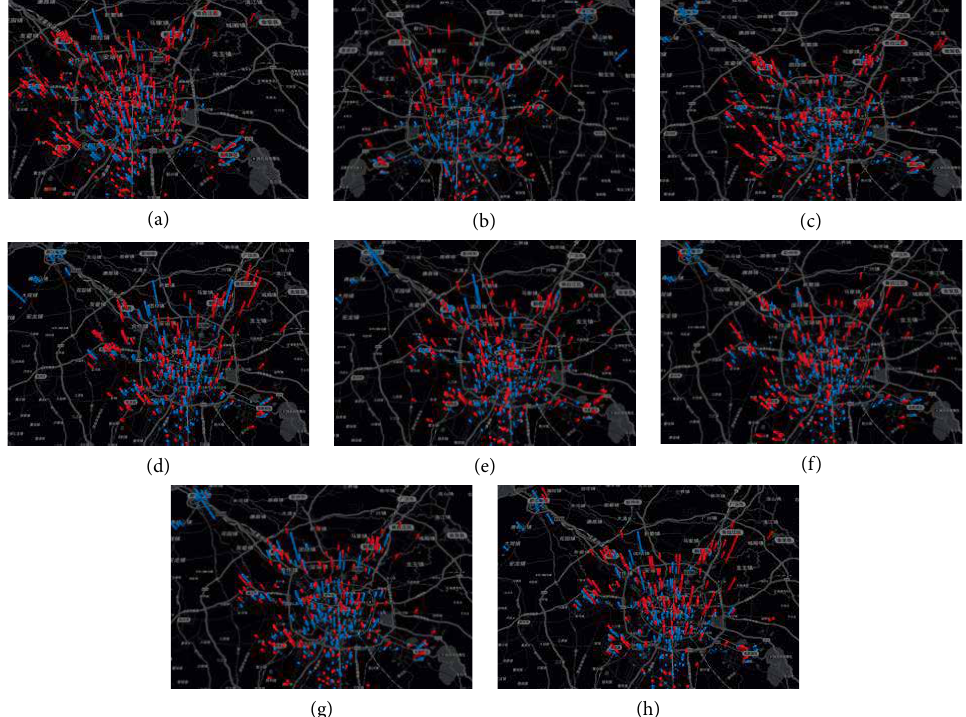
Figure 12: Predicted pick-up demand distribution on map during different time periods. (a) 00:00–07:00. (b) 07:00–09:00. (c)